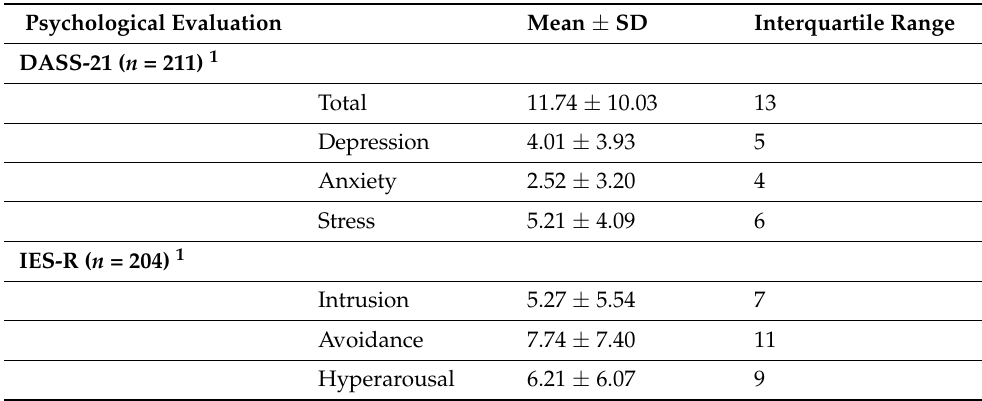
Table 2. DASS-21 and IES-R scores of the study